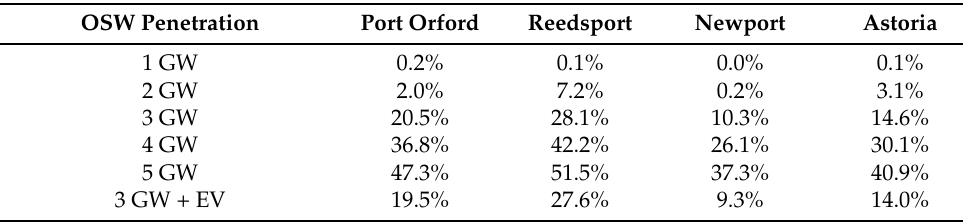
Table 3. Wind curtailment associated with different penetration levels of OSW.